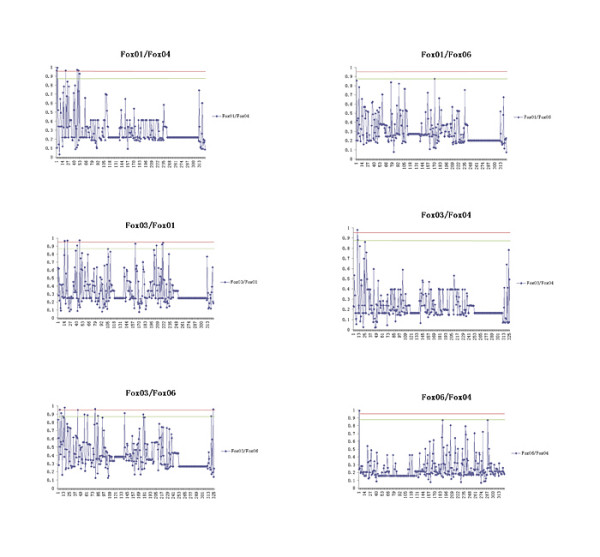
Type I functional divergence among the FoxO members. Posterior probability (PP) profiles of the site-specific type I functional divergence. The positions with gaps involved in each paralogous comparison were not considered. Red line indicates cutoff = 0.95, while green cutoff = 0.87.